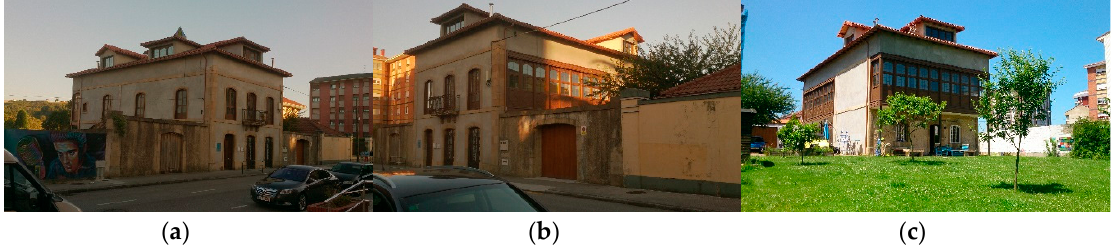
Figure 1. External views to the TAH : ( a ) from the north, ( b ) from the west, ( c ) from the south.